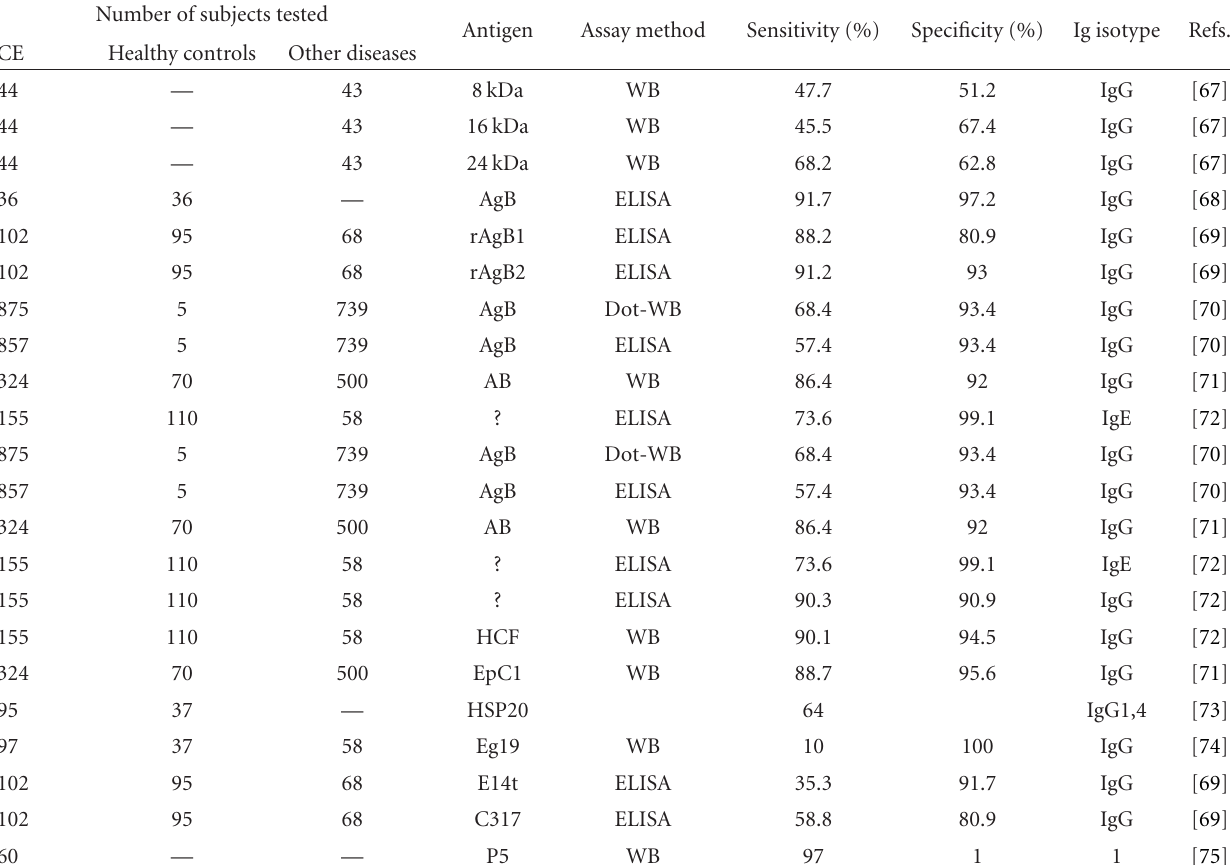
Table 1: Characteristics of assays using di ff erent antigens from E. granulosus developed after 2003 for immunodiagnosis of cystic